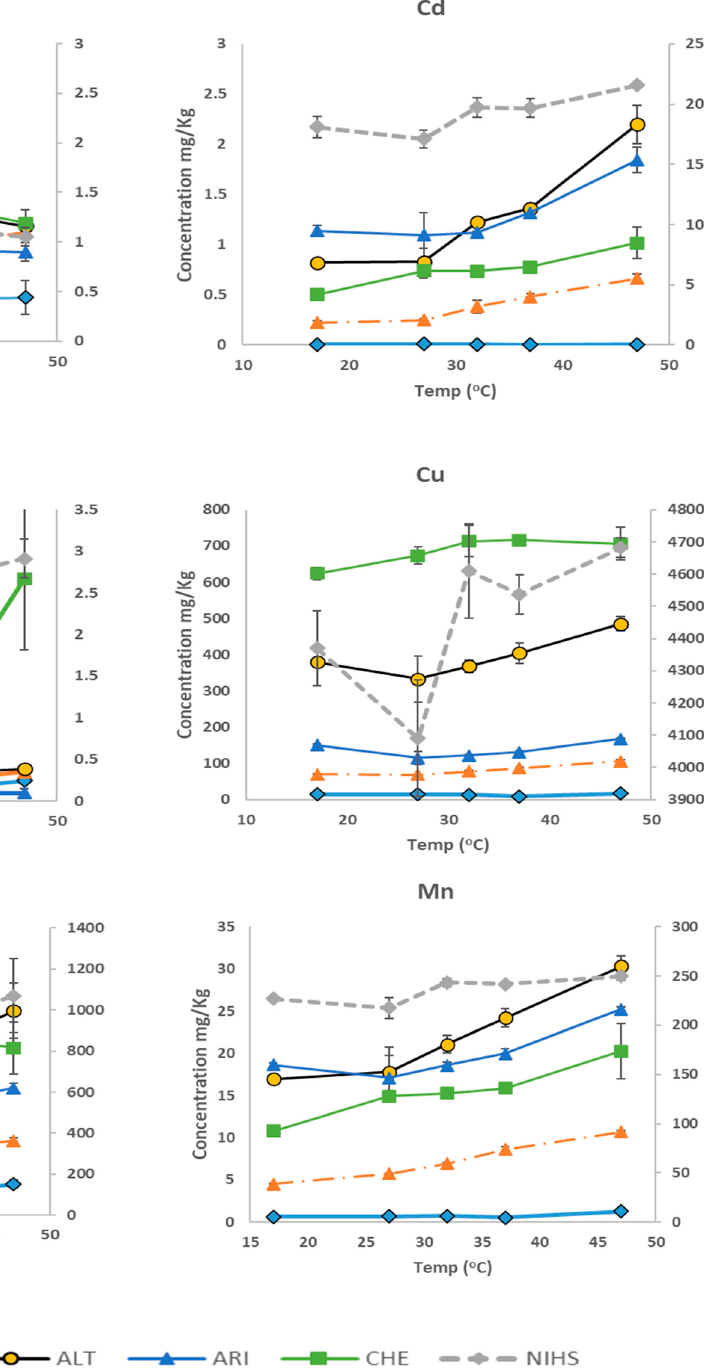
Figure 3. Dermal bioaccessible concentrations of Ni, Pb and Zn in bulk composite soil sample using different artificial sweat solutions and extraction temperatures. Results are plotted against the primary ( left-hand ) axis except NIHS, which is plotted against the secondary ( right-hand ) axis.